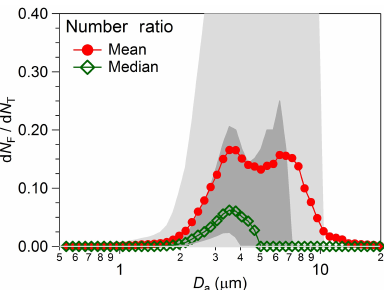
Figure 6. Size distribution of the FBAP to TAP ratio aver- aged over the entire measurement period carried out at Munnar (d N F / dlog D a = d M F / dlog D a ) . The lower and upper parts of the dark and light shaded areas represent the 5th, 25th, 75th, and 95th percentiles,